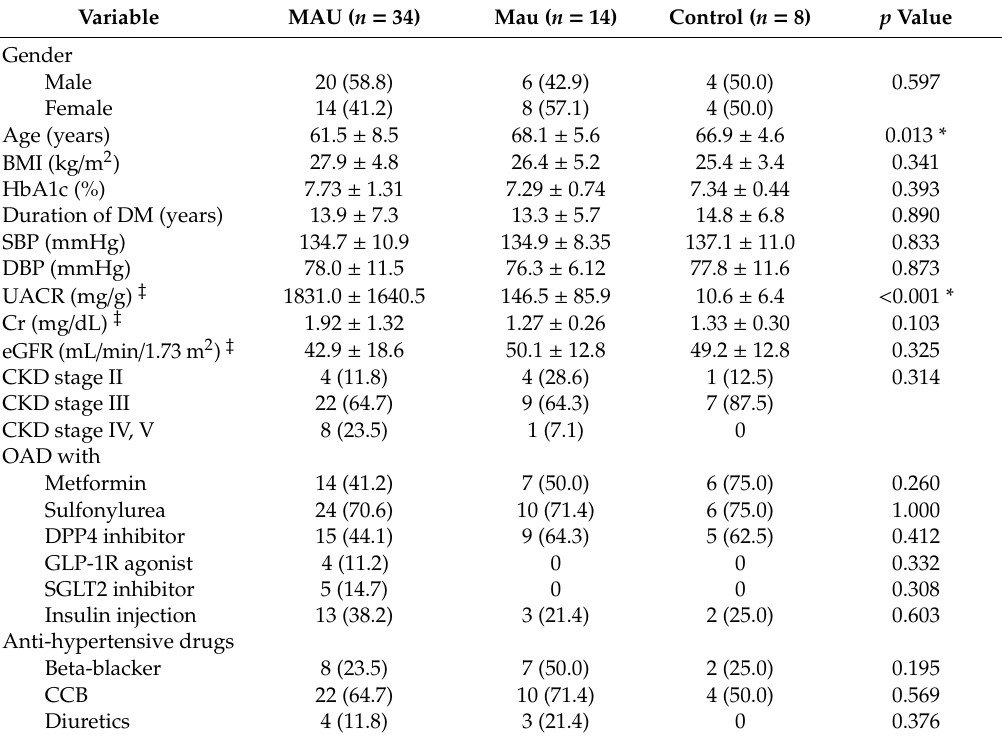
Table 1. Characteristics of 56 patients with various levels of albuminuria.